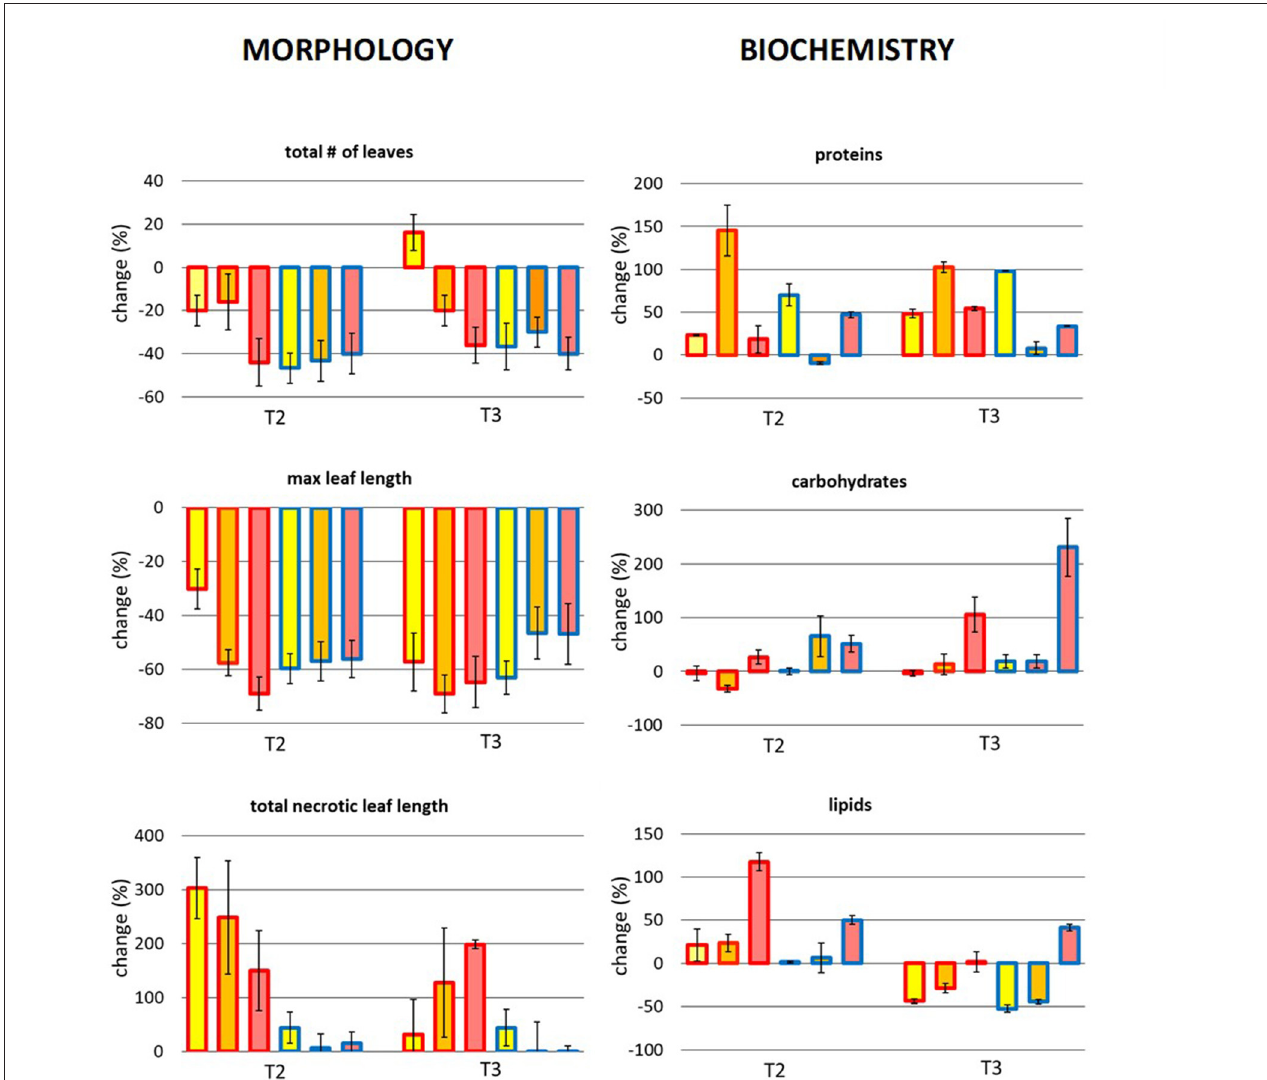
FIGURE 8 | Future MHWs. Mean change (%) in the morphological (total of leaves, max leaf length, and total necrotic leaf length) and biochemical variables (proteins, carbohydrates, lipids) at T2 and T3. Bar color corresponds to the temperature area: yellow = CT, orange = MT and red = HT. Border color corresponds to the plant origin: red = warm site and blue = cold